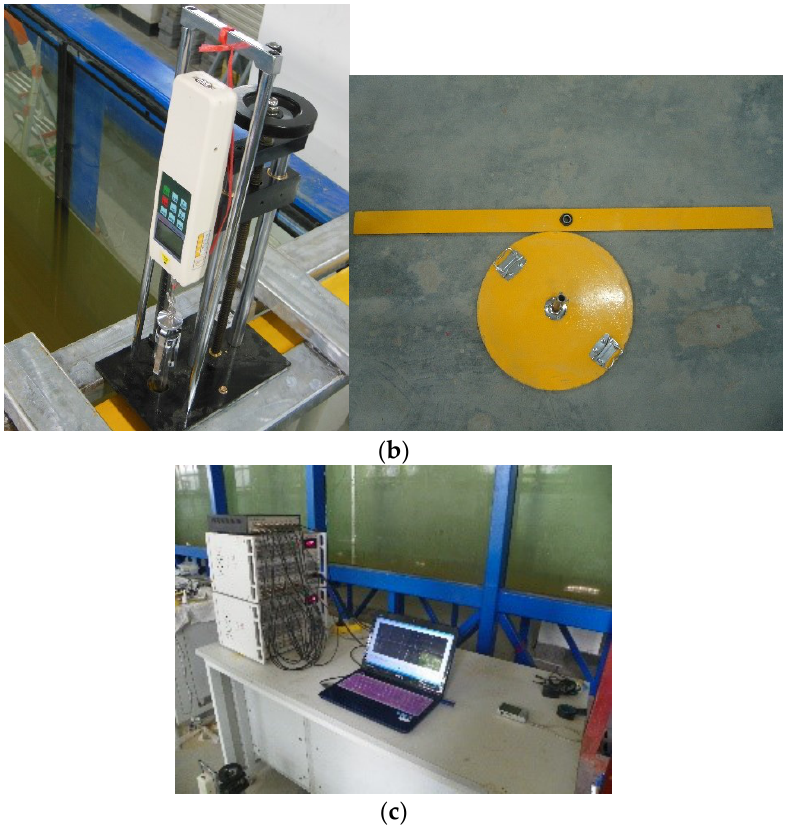
Figure 1. Testing instrumentation. ( a ) Current generation system; ( b ) velocity monitoring system; ( c ) end condition system; ( d ) data acquisition system.